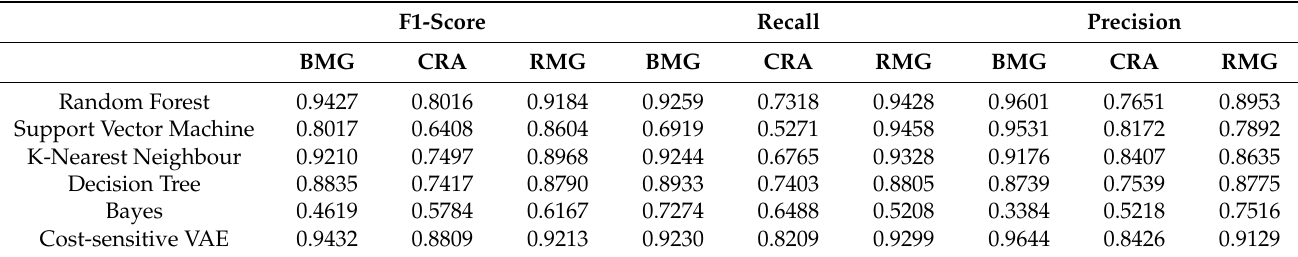
Table 3. F1-score, Recall, and Precision of different